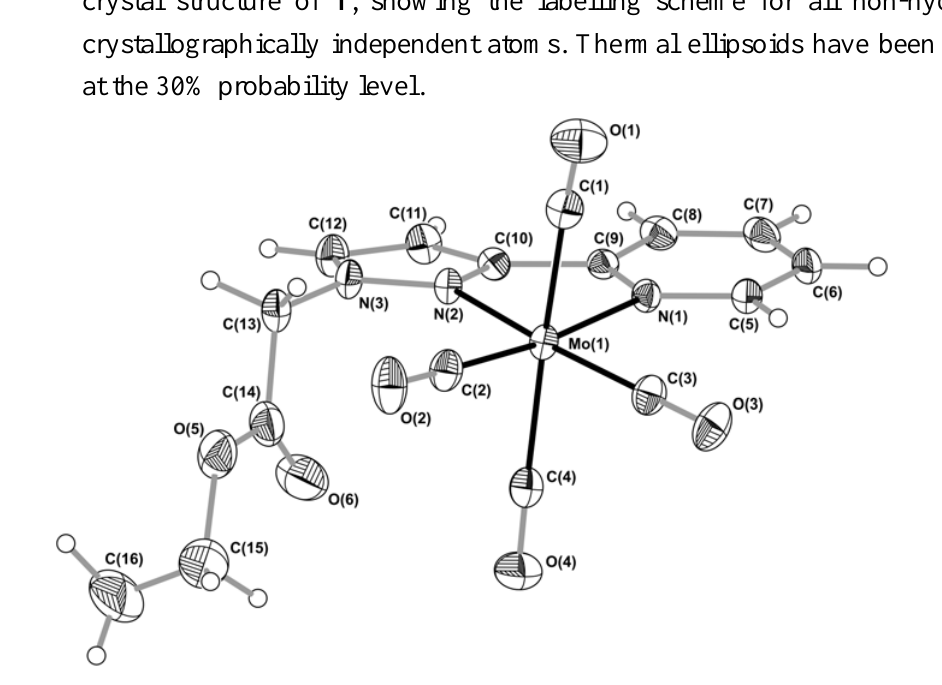
(pzpy)] present in the 4